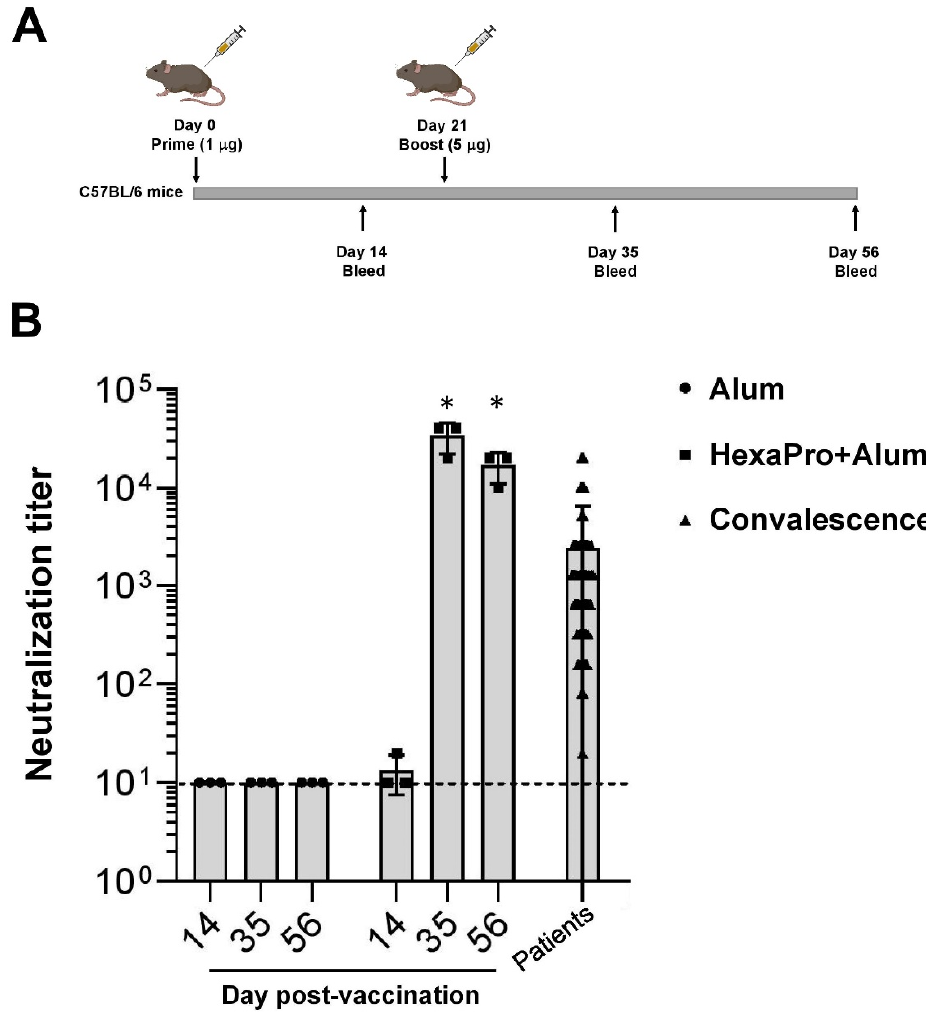
Figure 3. The prime-boost regimen using the recombinant HexaPro adjuvanted with aluminum hydroxide results in sera possessing neutralization activity. ( A ) C57BL/6 mice were vaccinated intramuscularly with Alum or HexaPro (1 µg) + Alum. On day 21 they then received a booster dose with HexaPro (5 µg) + Alum. ( B ) The virus neutralization endpoint titer of sera collected from mice and from convalescence sera. The dashed line shows the limit of detection. Neutralization activity on days 35 and 56 was compared to day 14. The error bars indicate the ±SD. Comparisons were performed using Student’s t -test (unpaired, two tail); * p < 0.01 (made in ©BioRender-biorender.com). (accessed on 2 March